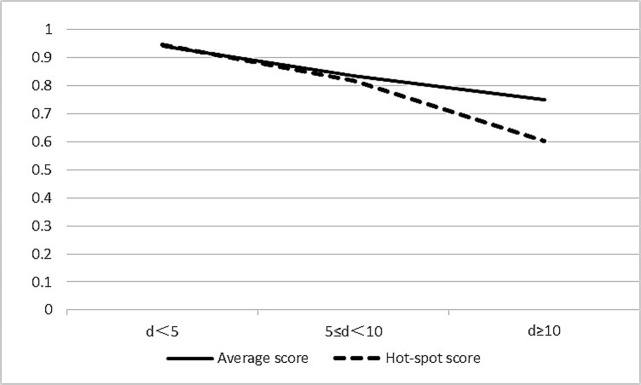
The correlations between ICC and paired-difference between Ki67 LI means of two score methods.The ICC was observed to decrease with increasing paired-difference between means of hot-spot score and average score. X axis: paired-difference (d) between Ki67 LI means of two score methods; y axis: ICC.